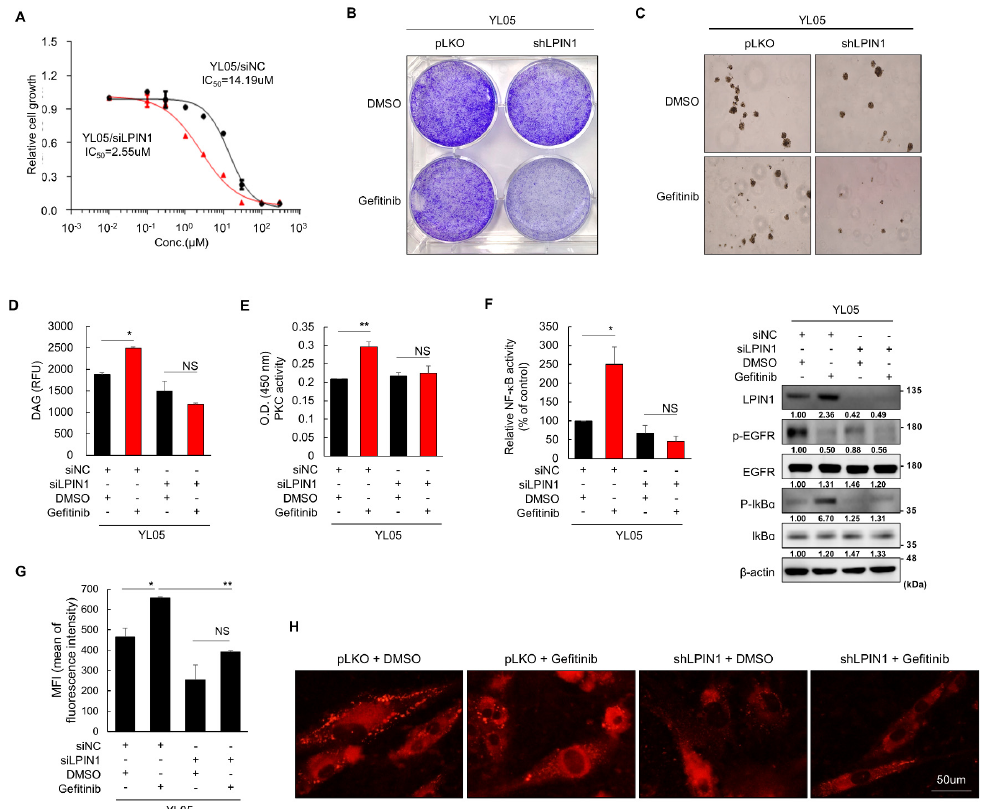
Figure 5. Patient-derived EGFR mutant NSCLC cells show LPIN1-dependent gefitinib resistance via PKC δ signaling induction. ( A ) Gefitinib-resistant lung cancer PDCs (YL05) were transfected with